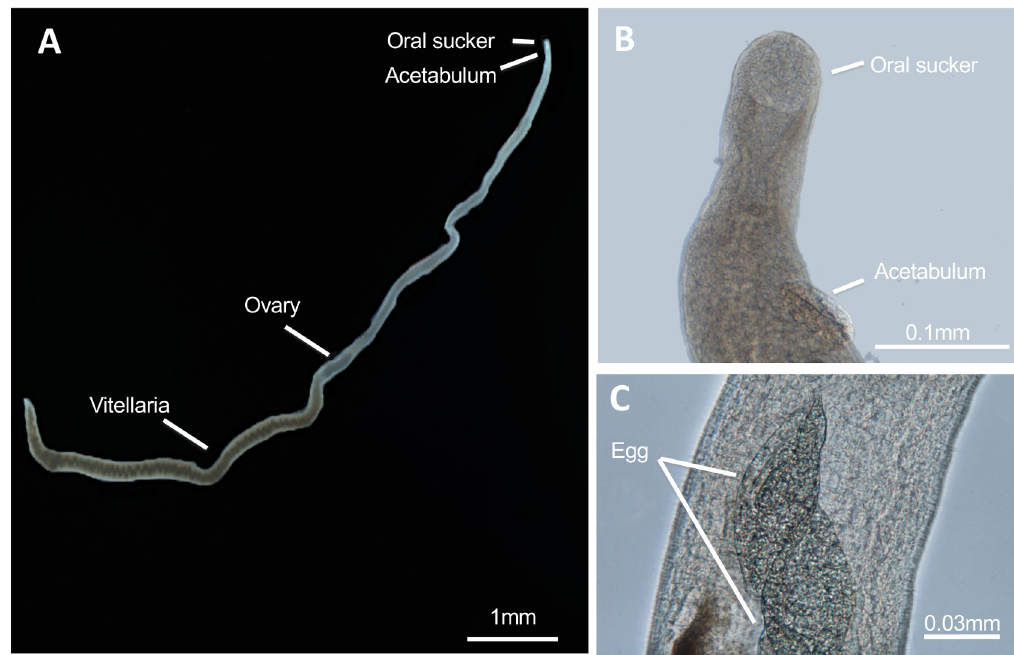
Fig 3. Morphological observations of the European female hybrid adult worms. (A) Lateral view of whole parasite body showing oral sucker, acetabulum (ventral sucker), ovary and vitellaria; (B) Frontal view of anterior region showing oral sucker, acetabulum (ventral sucker) in detail; (C) Dorso-lateral view of two eggs inside female uterus.